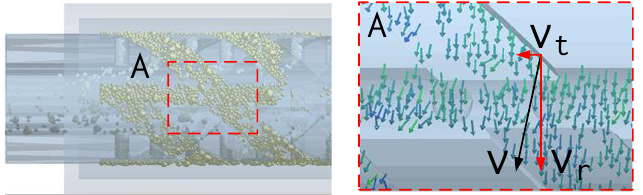
Figure 8. Drilling cutting distribution on grooves shape at 0.8 s and velocity vectors.